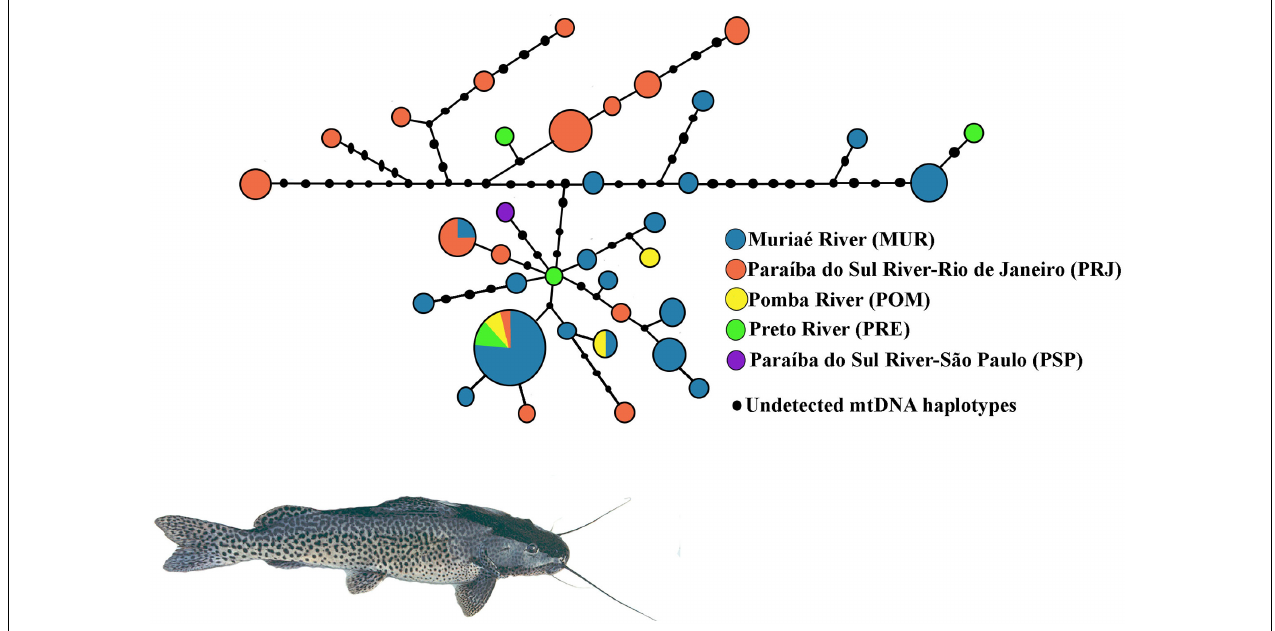
FIGURE 3 | Unrooted haplotype network for mitochondrial D-loop sequences of Steindachneridion parahybae generated by NETWORK 4.1.1.2 based on the median-joining algorithm. The sizes of the respective circles are proportional to the frequencies of the haplotypes at issue.